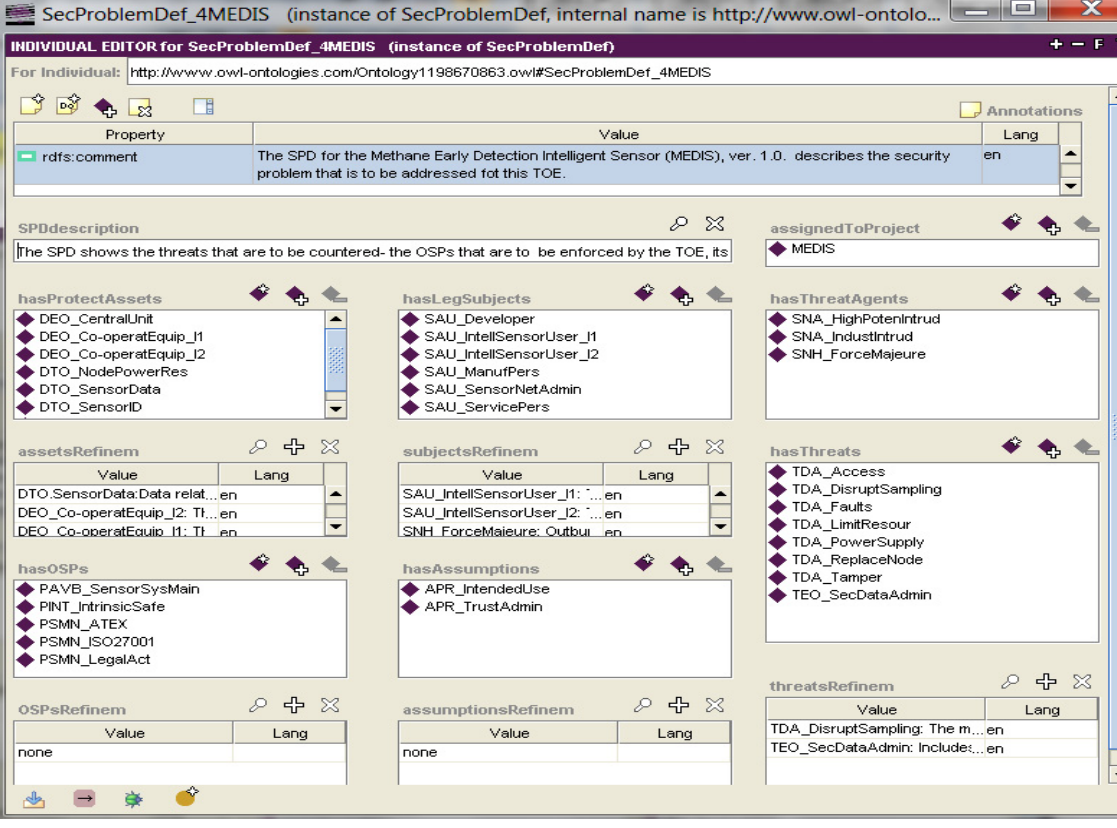
Figure 4. The threat representation in the knowledge base